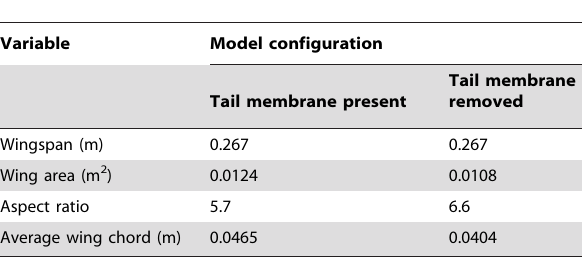
Table 1. Dimensions of wind-tunnel Plecotus auritus model, with and without the tail membrane present, showing that removal of the tail membrane reduces the wing area and average wing chord of the model and increases the aspect ratio.